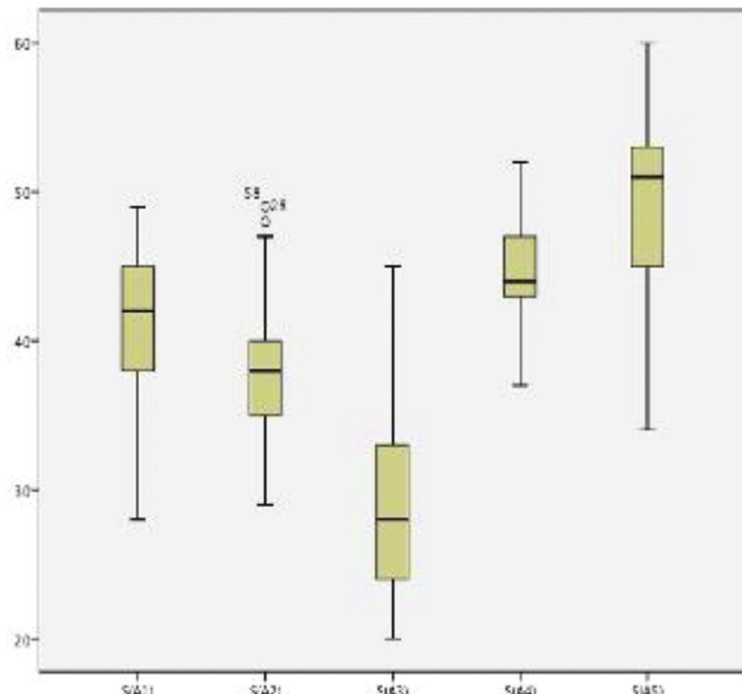
Figure 2 - Scores in end-to-end arterial anastomosis sessions. The box plots show the distribution of scores in end-to-end arterial anastomosis sessions. A gradual increase was observed ( p o 0.05).